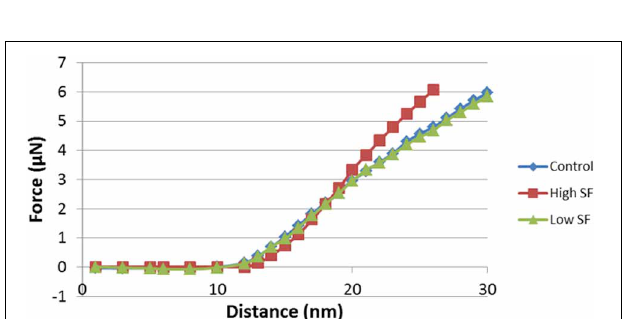
FIGURE 8 | Force-Distance curves obtained on RBCs from healthy individuals, normal serum ferritin (SF) Alzheimer’s (AD) individuals and high serum ferritin (SF) Alzheimer’s (AD) individuals. Force-Distance curves show the atomic force microscope (AFM) cantilever deflection range on the platelet